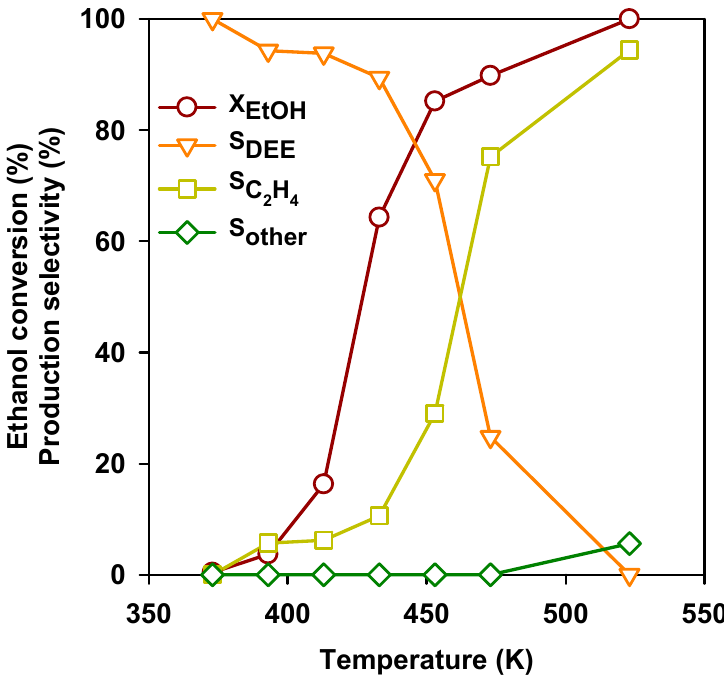
Figure 3. Ethanol conversion and selectivities to the products as a function of temperature over the H-mordenite zeolite. GHSV = 10,000 h − 1 and H-MOR with Si / Al 2 = 20.